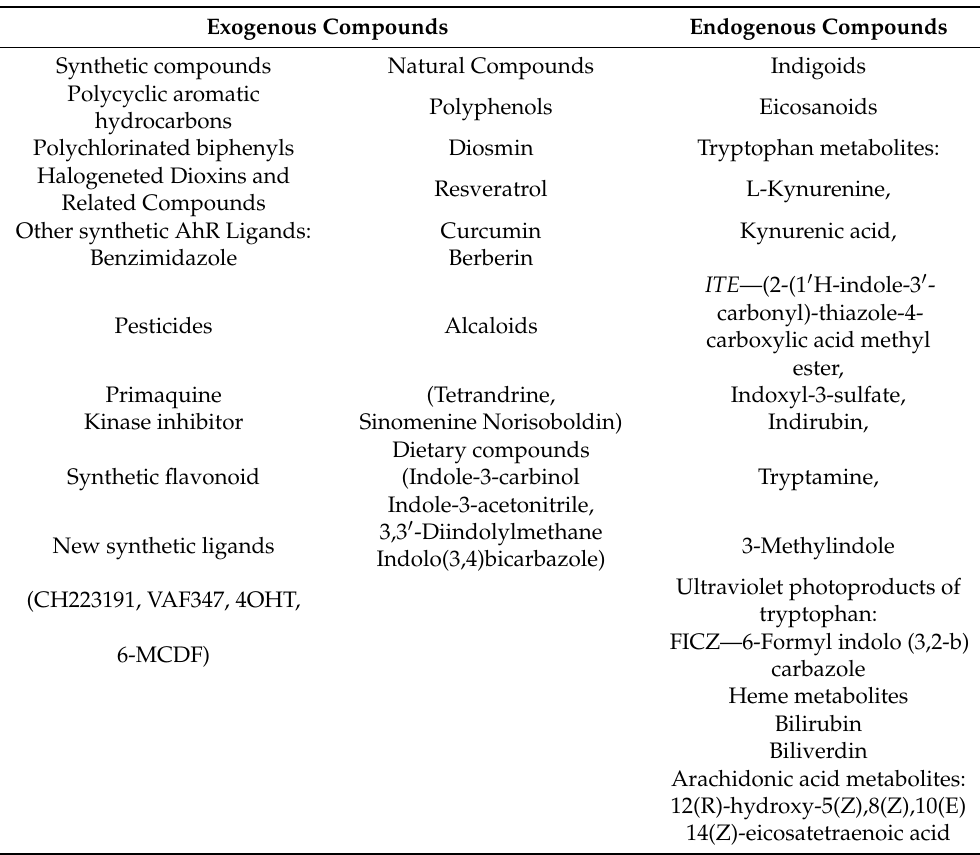
Table 1. The list of AhR ligands. Exogenous Compounds Endogenous Compounds Synthetic compounds Natural Compounds Indigoids Polycyclic aromatic Polyphenols Eicosanoids hydrocarbons Polychlorinated biphenyls Diosmin Tryptophan metabolites: Halogeneted Dioxins and Resveratrol L-Kynurenine, Related Compounds Other synthetic AhR Ligands: Curcumin Kynurenic acid,